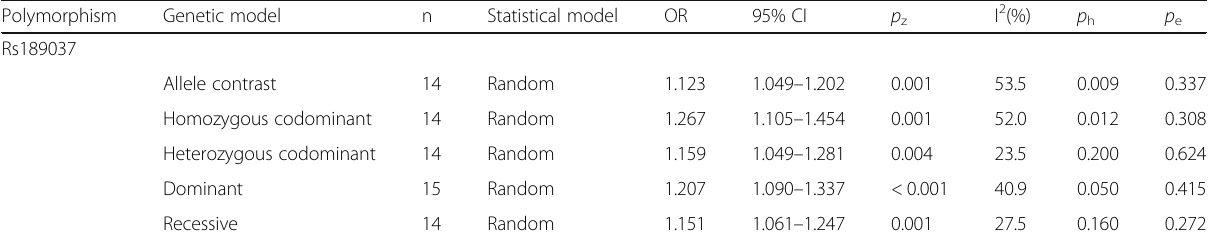
Table 3 Summarized ORs with 95% CIs for the association of ATM rs189037 polymorphism with cancer Polymorphism